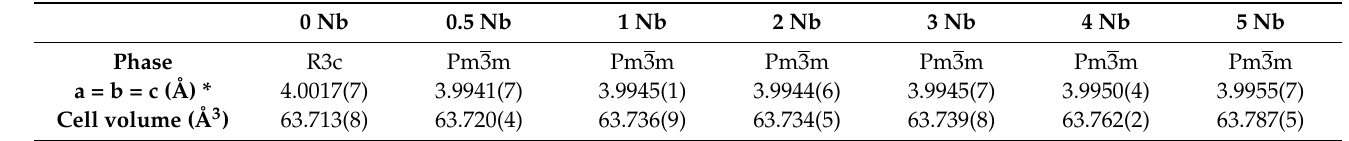
Table 1. Lattice parameters of 0.7BF–0.3BT–xNb ceramics determined by full-pattern refinement. Numbers in parentheses indicate the uncertainty in the least significant